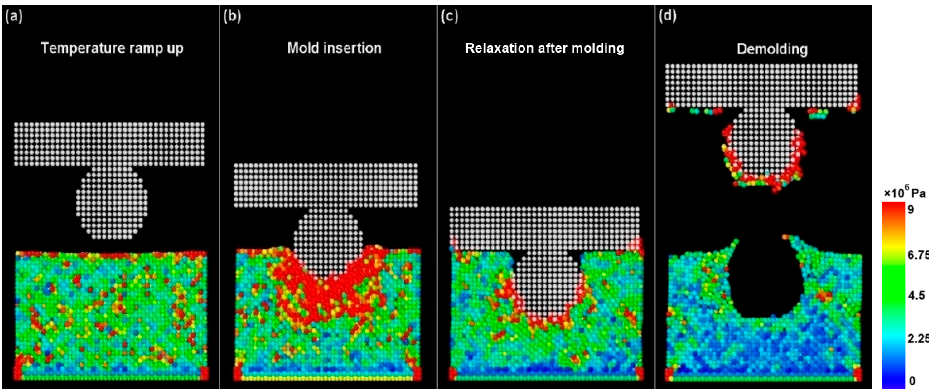
Figure 2. von Mises stresses during the NIL process using a spherical mold profile. Time steps for each phase of NIL: ( a ) 50,000, ( b ) 38,000, ( c ) 50,000, and ( d ) 160,000.